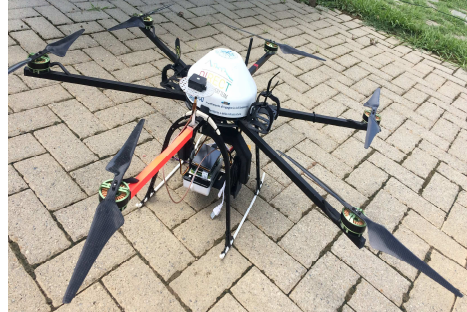
Figure 1. The employed multi-rotor platform used for the image acquisition